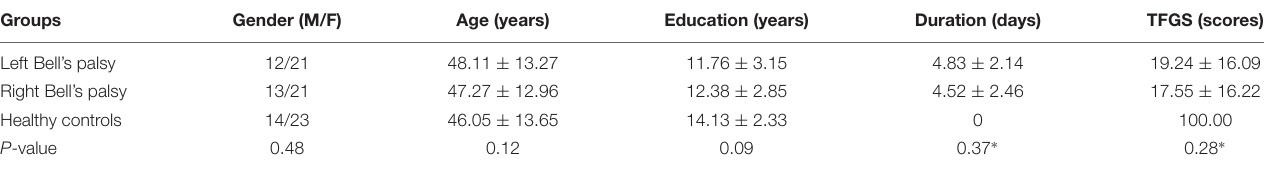
TABLE 1 | Demographic and clinical data of the study